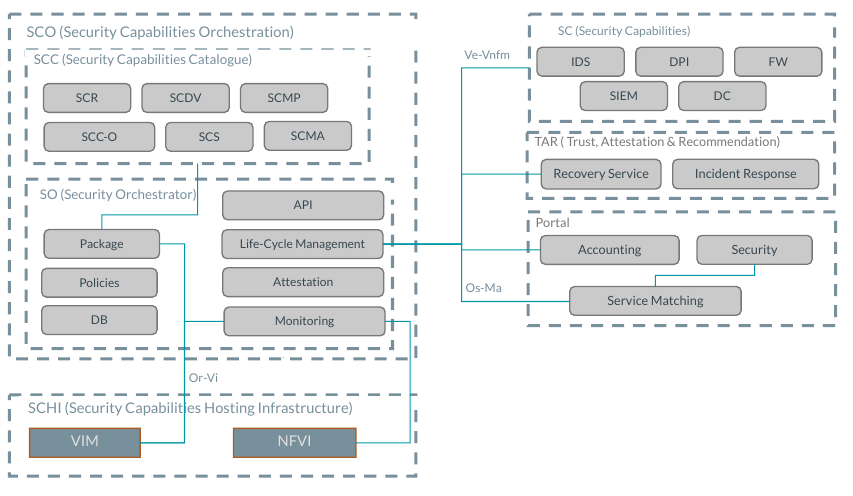
Figure 1. PALANTIR general